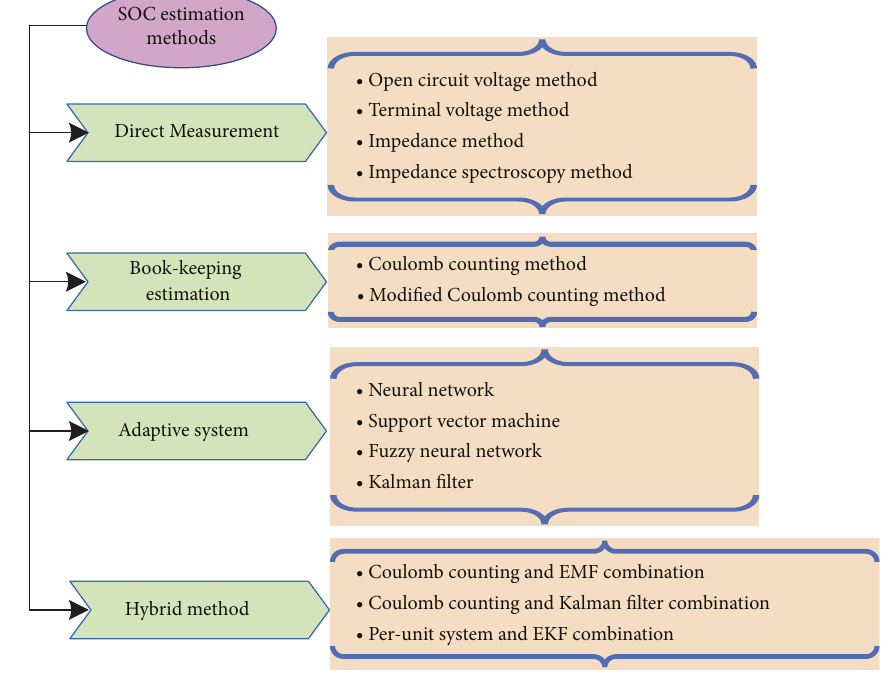
Figure 15: Methods of SOC estimation. Table 3: Comparison of the direct measurement method of SOC estimation.